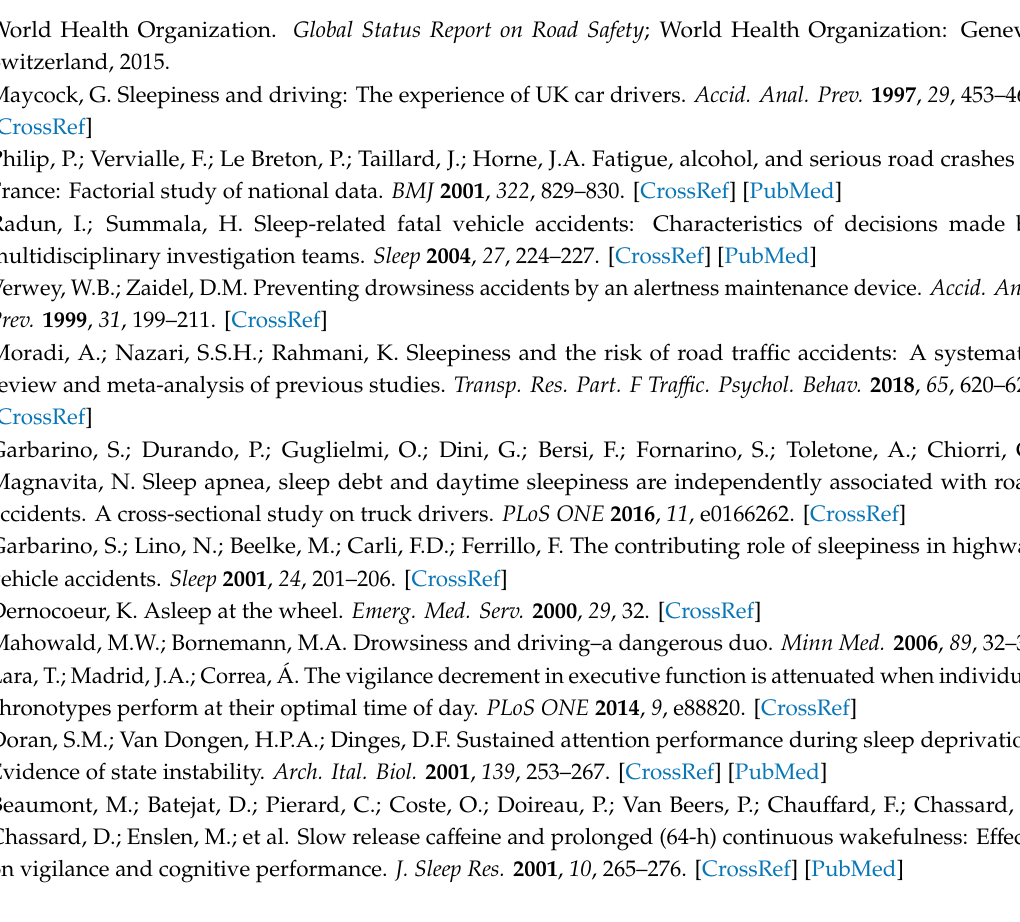
Table S1: Results of multiple regression model with the control for gender; Table S2: Results of multiple regression model with the control for gender, excluding the age